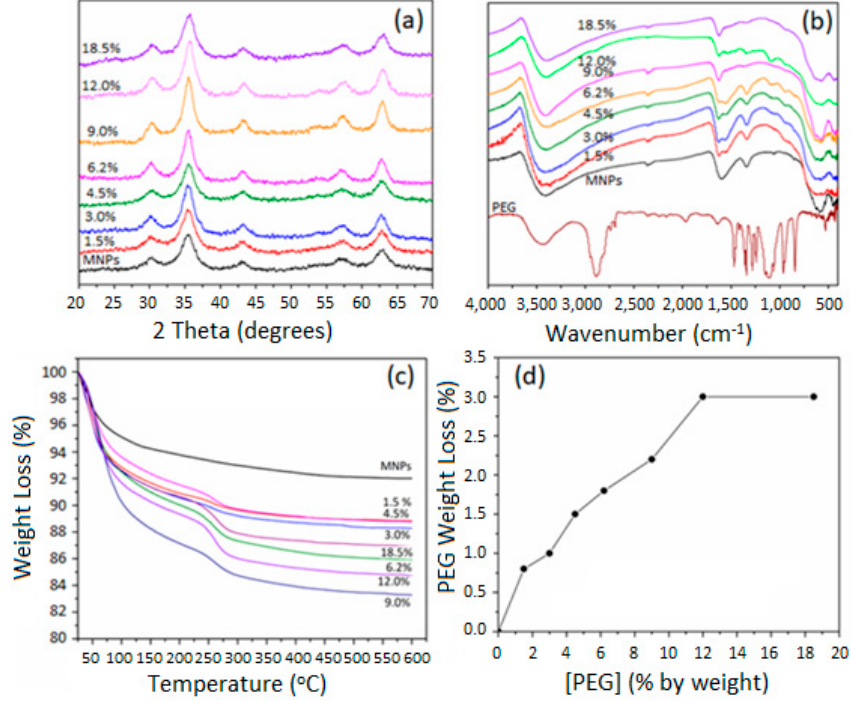
Figure 2. ( a ) XRD patterns of the PEG-coated MNPs as a function of the concentration of PEG, ( b ) FT-IR spectra of the PEG-coated MNPs as a function of the concentration of PEG, ( c ) TGA thermograms of the PEG-coated MNPs as a function of the concentration of PEG, ( d ) the extent of coating of MNPs with PEG as depicted from their TGA thermograms.